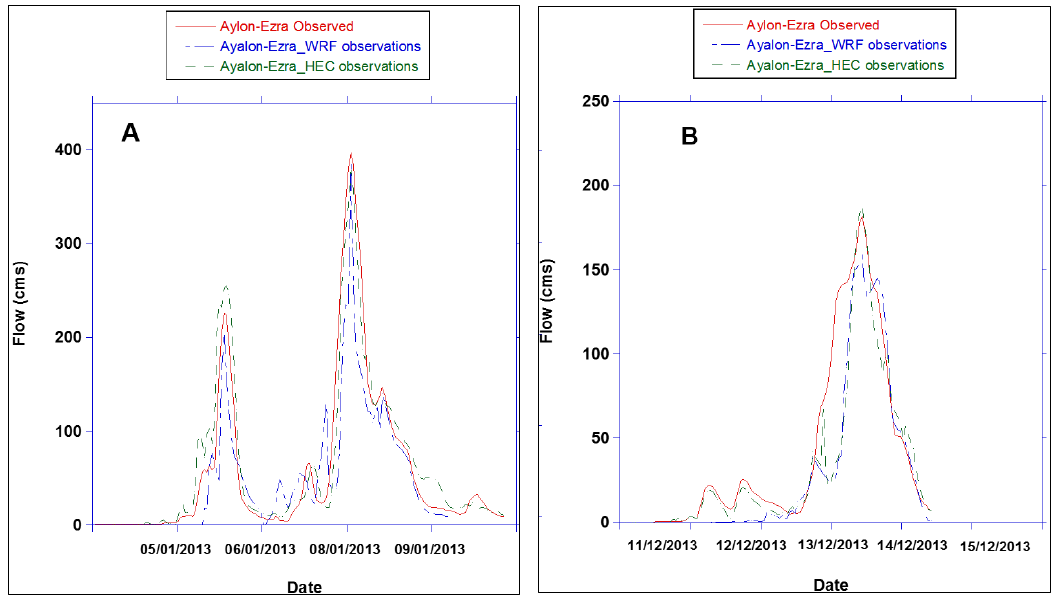
Figure 8. Observed hydrograph at Ayalon–Ezra hydrometric station ( red ) and simulate hydrographs using the Hydrological Engineering Center-Hydrological Modeling System (HEC-HMS) (in green ) and WRF-Hydro models using observed precipitation as an input for the January ( A ) and December ( B ) storms. The threshold for flood in this station is 200 cubic meter per second. Hydrology 2016 , 3 , 19